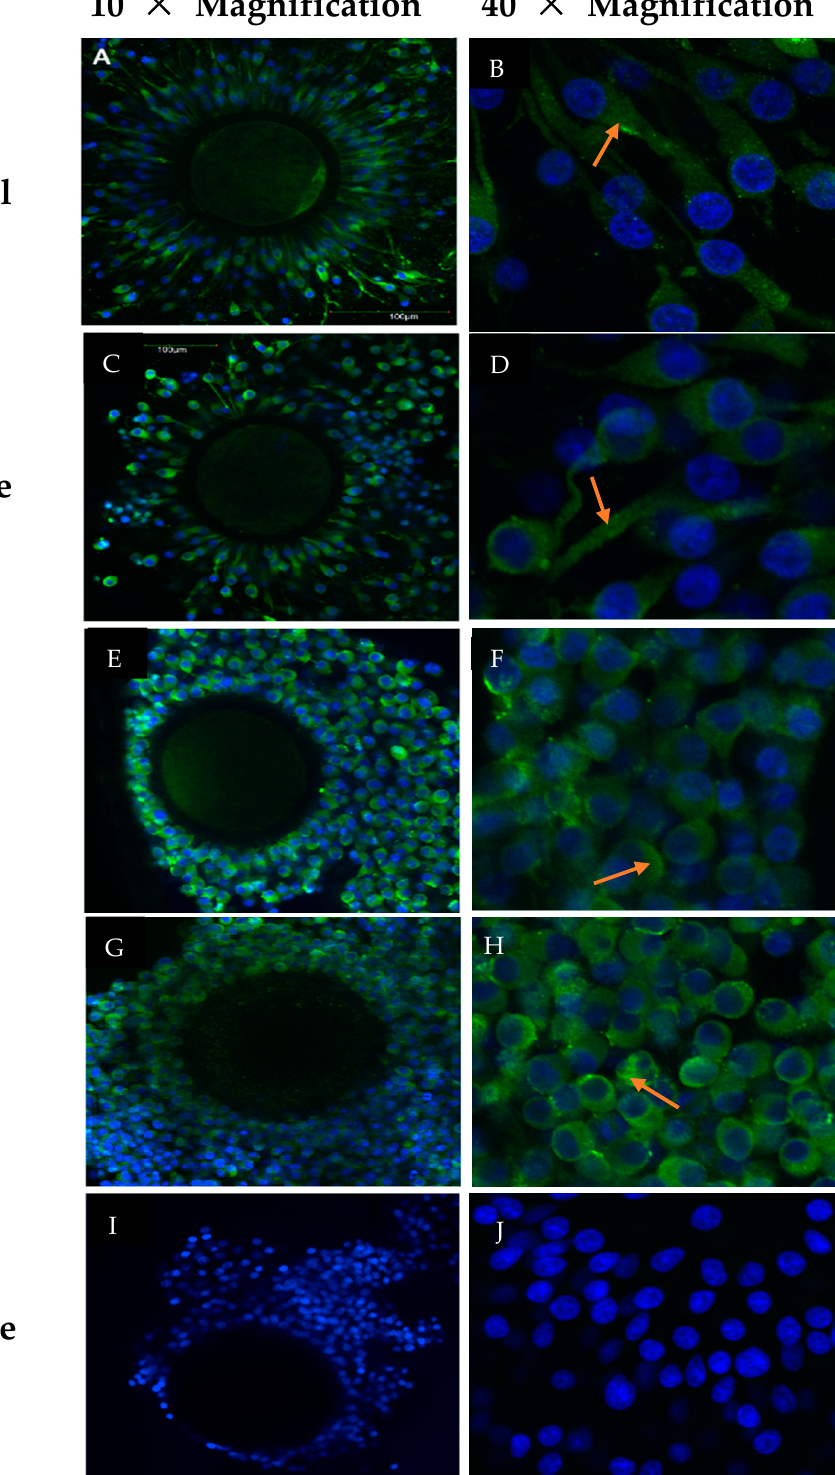
Figure 6. Confocal Microscopy of bovine COCs at 10 × and 40 × magnification. ( A–B ) S-IVM (control), ( C–D ) S-IVM with 0.1% ethanol (vehicle), ( E–F ) S-IVM + 0.1% 0.05 mg/mL BPA (BPA), and ( G–H ) Scheme 0. 0.05 mg/mL BPS (BPS). Blue: Hoechst (nucleic acid) stain, Green: Cx37 (Alexa Fluor 488) indicated by red arrows. ( I–J ) A negative control group was treated with PBS in place of 1 ◦ Ab at 40 × with the arrows pointing to Cx37 localization within the cytoplasm.